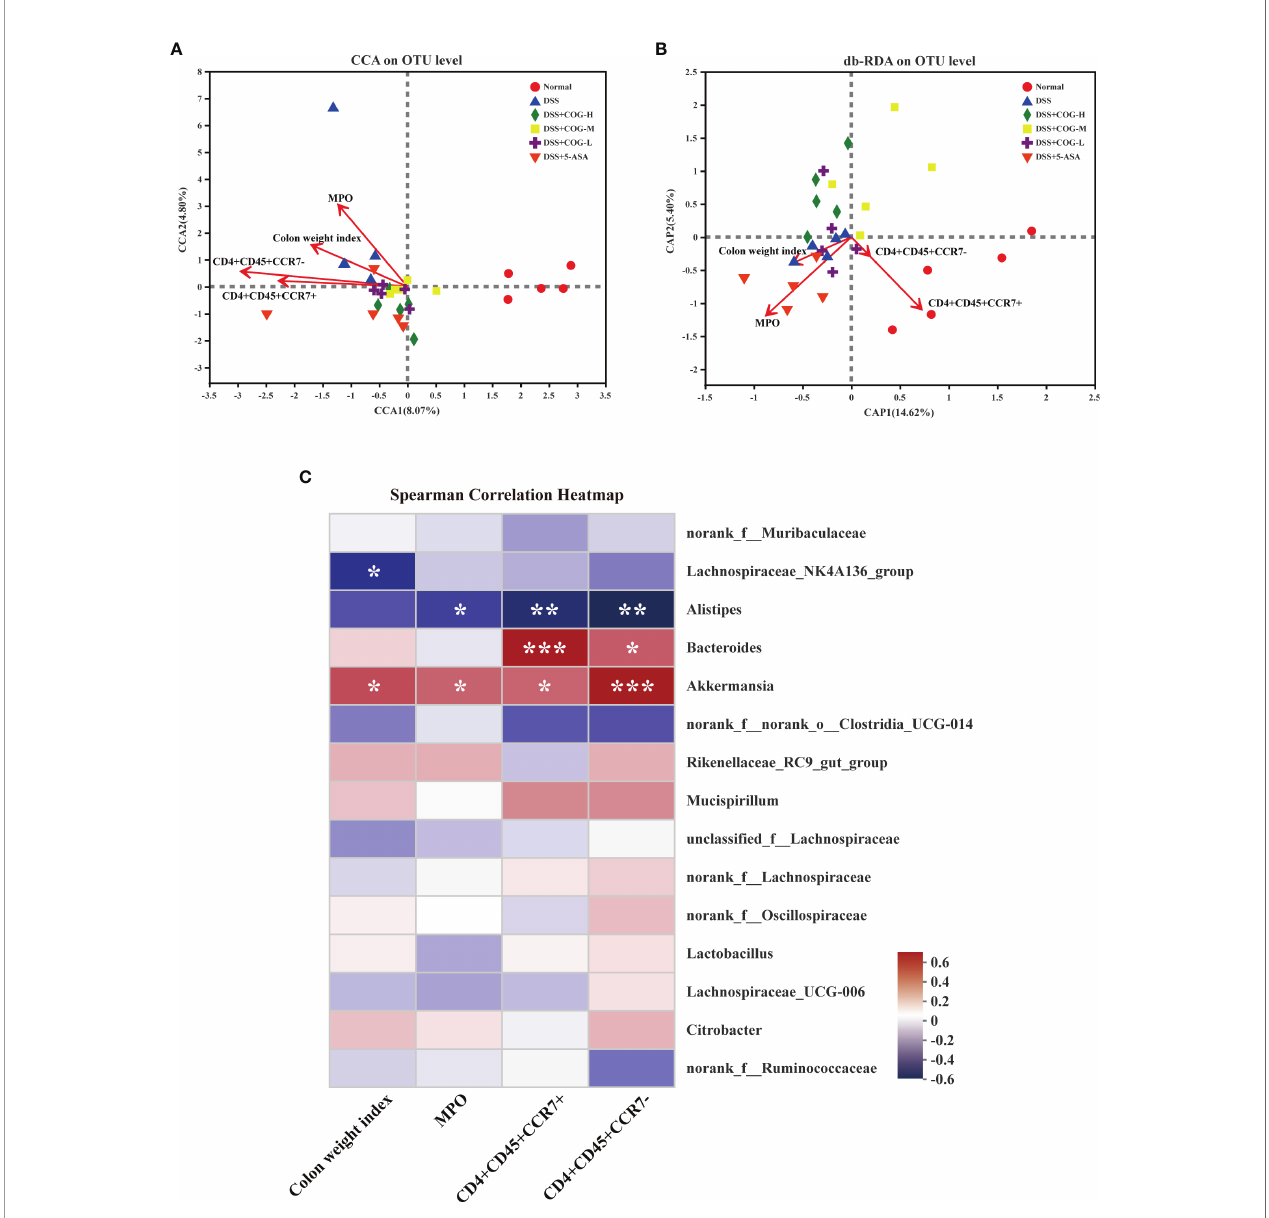
FIGURE 9 | COG regulated the correlation among oxidative stress response, CCR7 + /CCR7 − T lymphocytes, and gut micro fl ora in colitic mice. (A) Correlation among colonic index, MPO, and CCR7 + /CCR7 − T lymphocytes displayed by canonical correlation analysis (CCA). (B) Correlation among colonic index, MPO, and CCR7 + /CCR7 − T lymphocytes displayed by distance-based redundancy analysis (db-RDA). (C) Spearman ’ s correlation heatmap of colonic index, CCR7 + /CCR7 − T lymphocytes, MPO, and gut micro fl ora. n = 5. *P ≤ 0.05, **P ≤ 0.01, ***P ≤